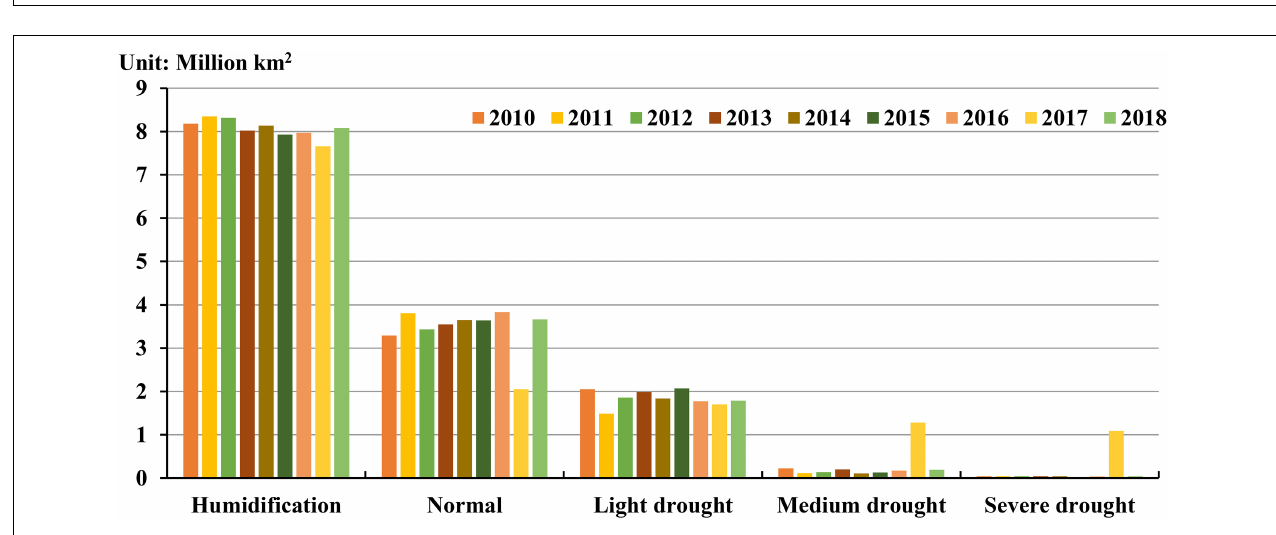
FIGURE 6 | The area of different drought grades for AGE from 2010 to 2018.